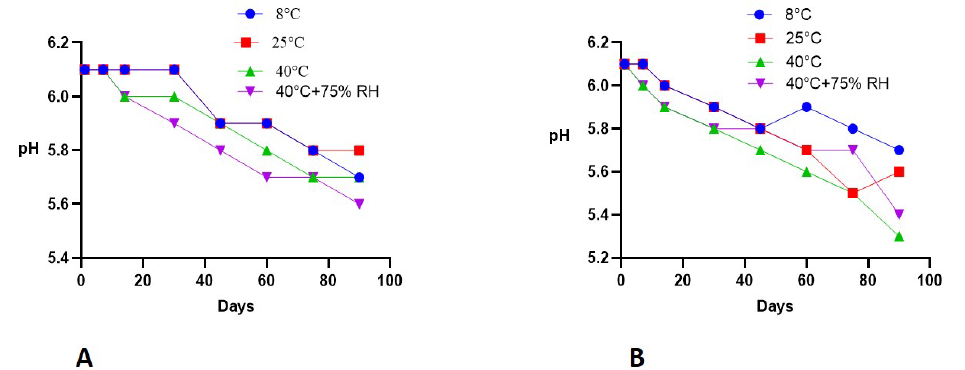
Figure 3. pH changes of ( A ) (placebo) and ( B ) (formulation) with time kept at different storage conditions (mean ± SD, n = 3).